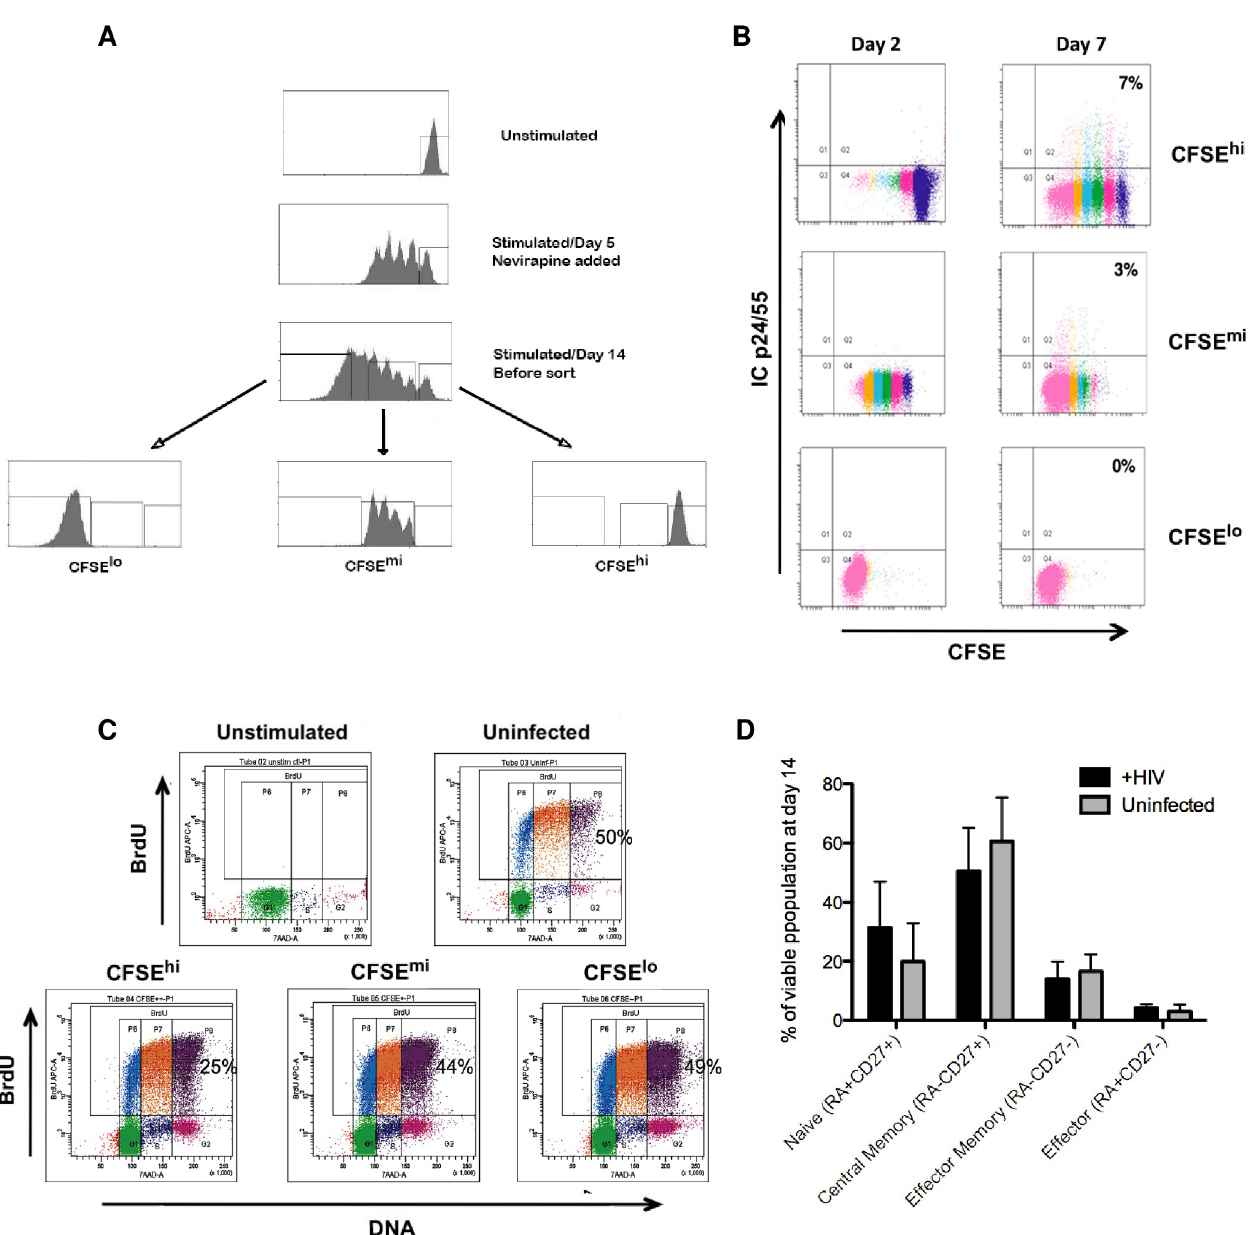
Fig 4. Latent infection is established in CD4 T cells that do not divide in response to TCR stimulation. (A) Representative example of the experimental design for identification and sorting of cell subsets with different proliferation profiles. CD4 T lymphocytes were prepared and cultured as described in Fig 3C. Nevirapine, RT inhibitor was added on day 5. At the end of culture (day 14), cells were sorted based on their CFSE content and proliferation profile into subsets that had: i) not divided (CFSE hi ); ii) divided only a few times after day 5 (CFSE mi ); or iii) divided many times after day 5 (CFSE lo ). (B) Infected cell subsets, recovered from sorting on day 14, were washed and restimulated with immobilized anti-CD3 + anti-CD28 to induce a second round of productive virus replication. Each recovered cell subset was analyzed by flow cytometry for expression of intracellular Gag (ICp24/55) at 2 and 7 days, following reactivation. Representative data, from one of 4 experiments, are shown. (C) Cell subsets isolated at the end of the initial culture phase (day 14) were tested for their capacity to respond to a second TCR stimulation. On day 4 following restimulation, aliquots from the uninfected control culture and each infected cell subset were analyzed by flow cytometry for cell status (7-AAD staining of DNA content) and level of active DNA synthesis (2 hr pulse with BrdU). Representative data, from one of 3 experiments, are shown. (D) Bar graph of infected (black) and uninfected (gray) cell subpopulations that were stained on day 14 for CD45RA and CD27 co-expression. Bars show the proportions of different T cell maturation phenotypes found in the CFSE hi subset of cultured cells that had not proliferated. Results depict the mean + SD of 4 experiments, using cells from different donors.